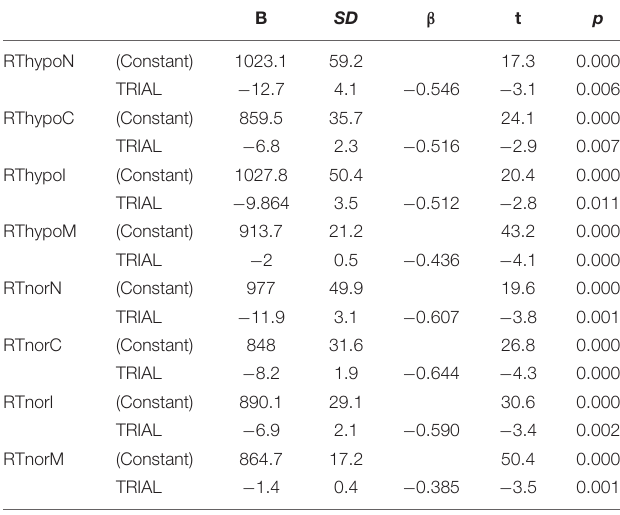
TABLE 1 | Linear regression between reaction times and trials number.